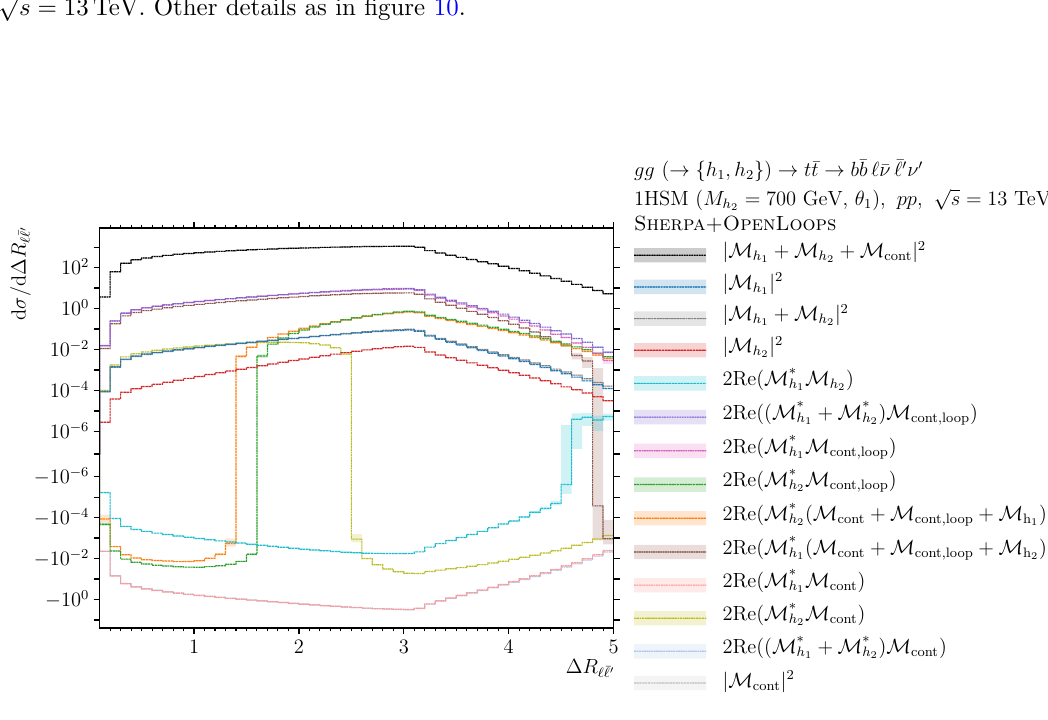
h 1 , h 2 ) t ¯ t b ¯ b (cid:25) ¯ ν ¯ (cid:25) (cid:31) ν (cid:31) in → { } → →